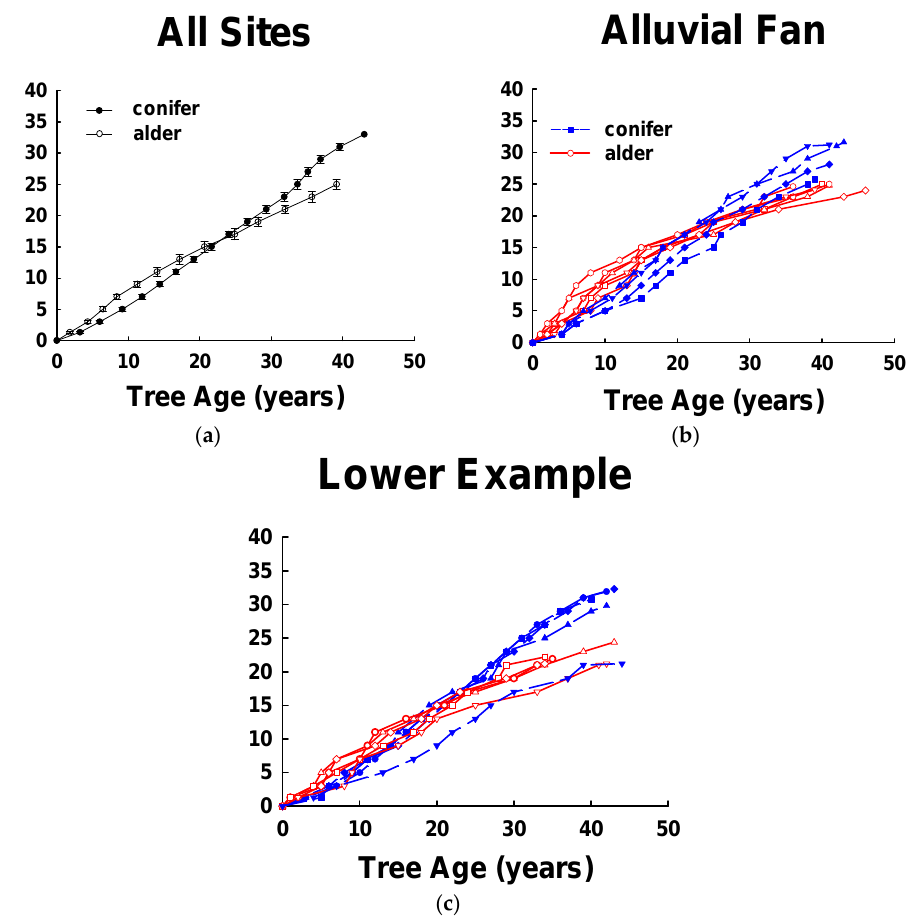
Figure 4. Height growth of dominant red alders and conifers (Sitka spruce and western hemlock) at study areas including ( a ) average of all sites; ( b ) average height growth for alders and conifers at an alder ‐ dominated site (64% alder); and ( c ) alder and conifer trees for a conifer ‐ dominated site (18% alder).